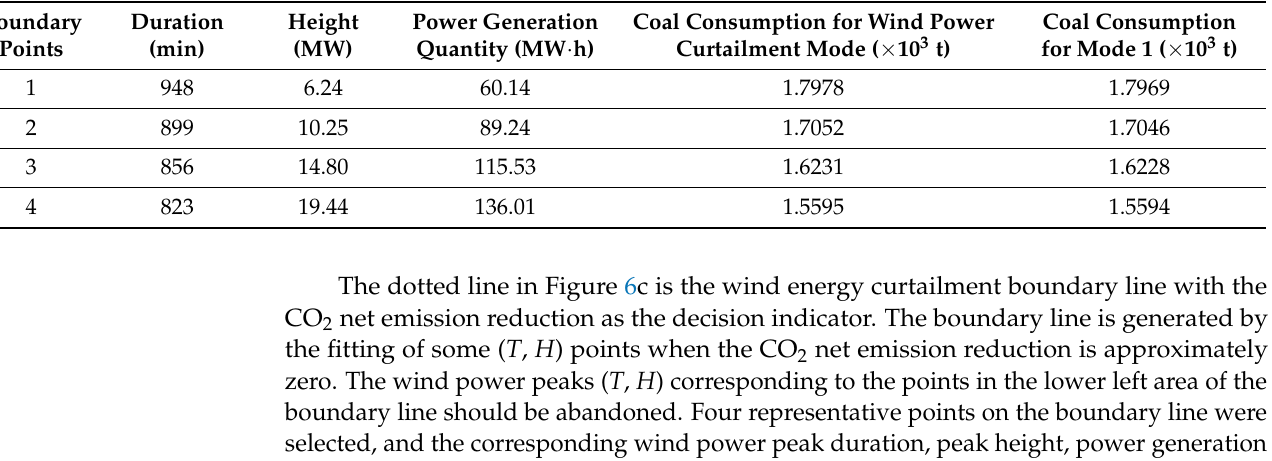
Table 4. Wind energy curtailment boundary with net coal saving as the decision target.